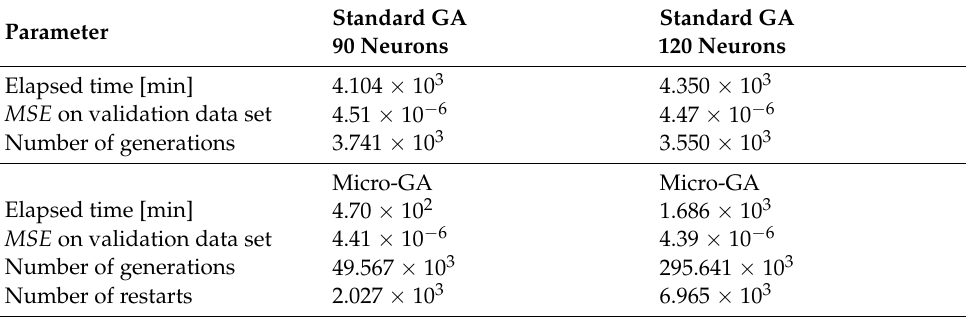
Table 3. The empirical assessment of the two presented GA algorithms.